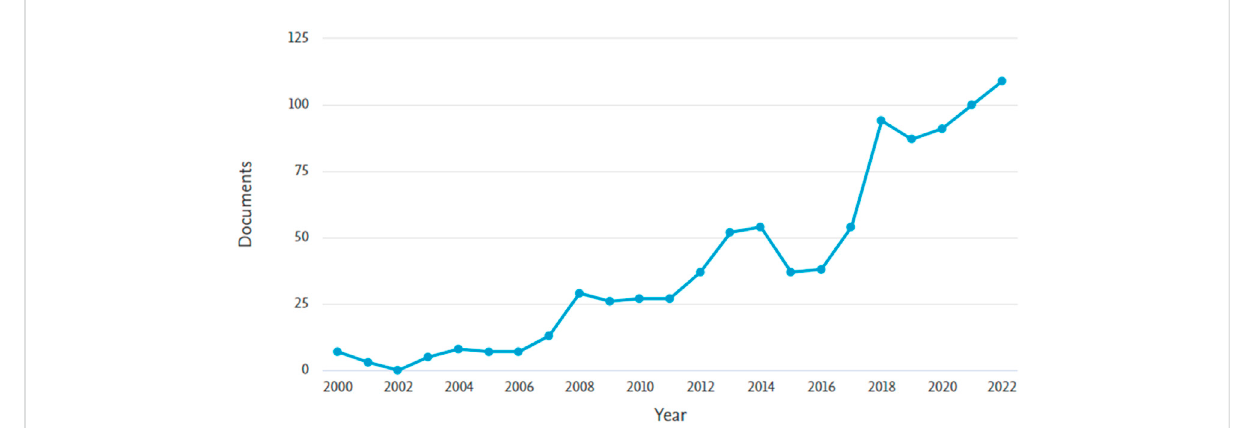
Annual publication trend of published articles on mineral fi ber-reinforced concrete research till December 2022.